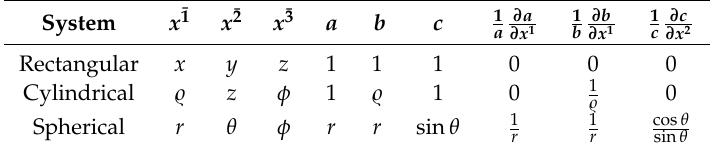
Table A1. Coordinates, metric functions, and metric derivatives for common curvilinear coordinate